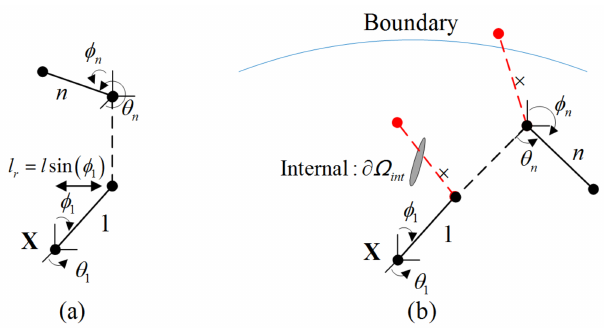
Figure 3. The distribution of polymer chains: ( a ) random distribution; ( b ) restricted distribution.